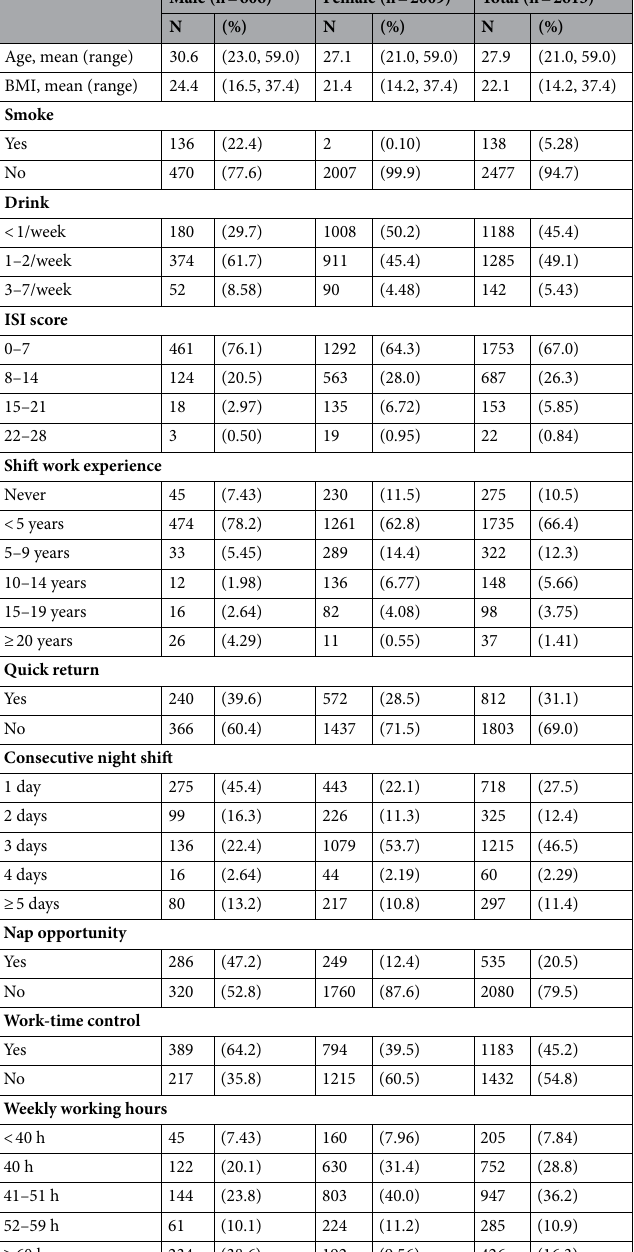
Table 1. General characteristics of the study participants at